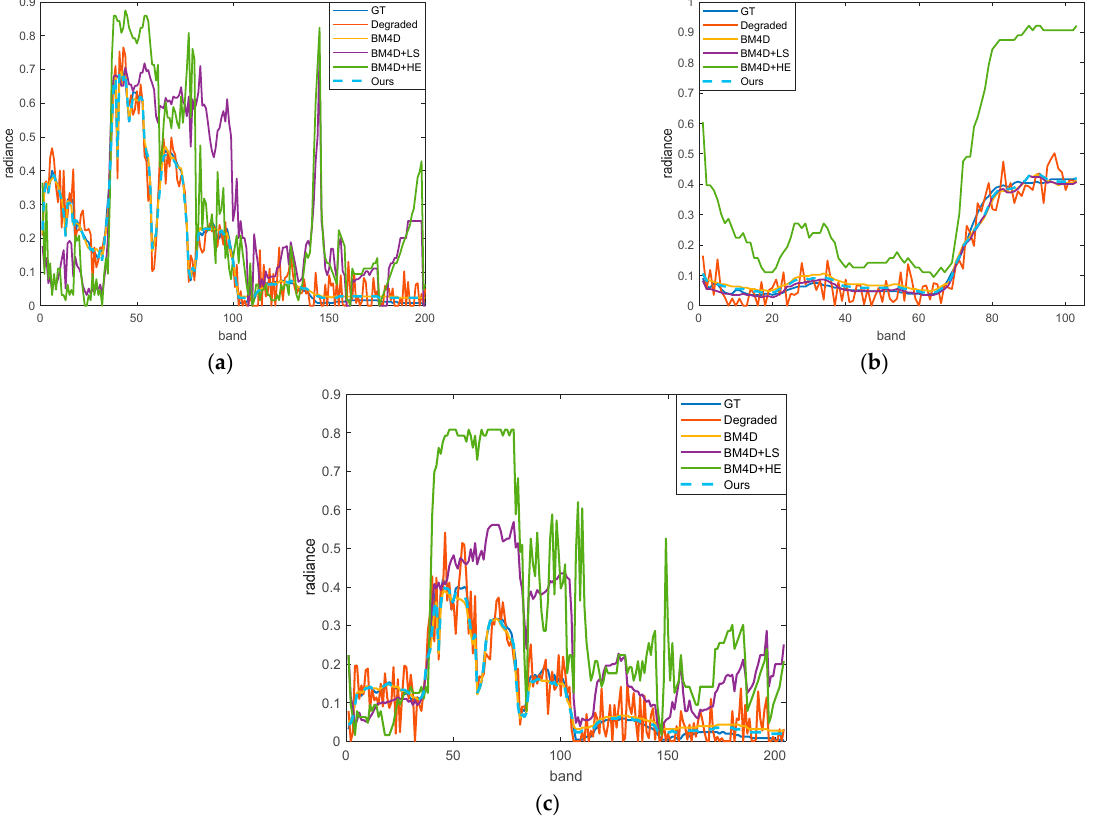
Figure 9. The spectral curve results of different comparison algorithms. Blue represents the original spectral curve, red represents the spectral curve of degraded data, yellow represents the curve results using the BM4D algorithm, purple represents the curve results using the BM4D + LS algorithm, green represents the curve results using the BM4D + HE algorithm, and blue represents the spectral curve after quality improvement. ( a ) The spectral curve at (111,111) in the Indian Pines dataset. ( b ) The spectral curve at (171,171) in the PaviaU dataset. ( c ) The spectral curve at (101,101) in the Salinas dataset.